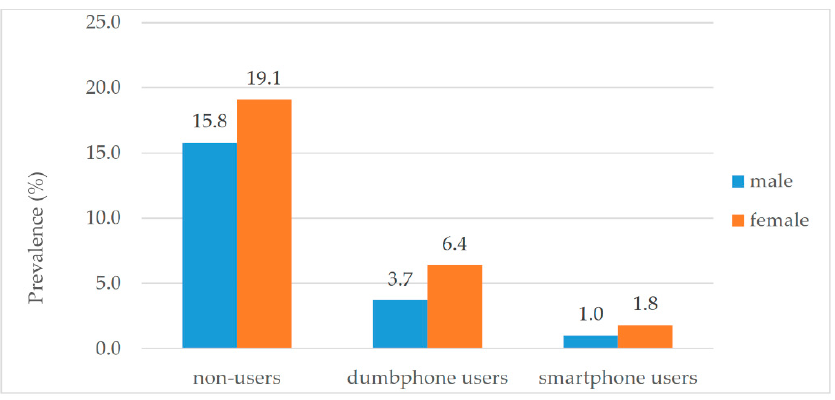
Figure 2. Prevalence of cognitive impairment in different mobile phone users.